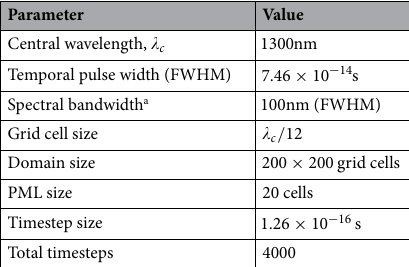
Table 1. Simulation parameters used in the Psuedo spectral time domain (PSTD) solver. a Equivalent spectral bandwidth derived from temporal width of illumination